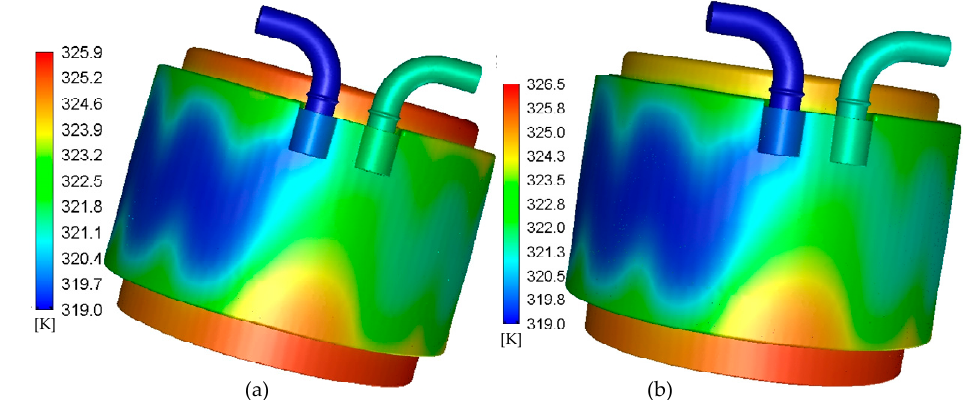
Figure 9. Shell temperature distribution. ( a ) Unidirectional coupling; ( b ) bidirectional coupling.